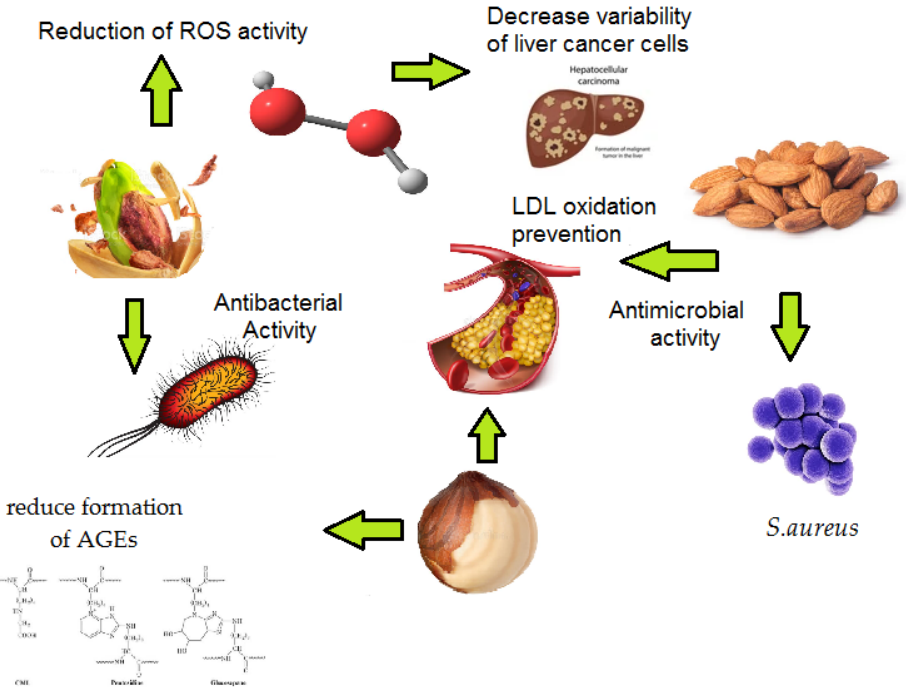
Figure 5. Mechanisms of action of almond, hazelnut, and pistachio skin on cancer cells, LDL oxidation, and antimicrobial activity.